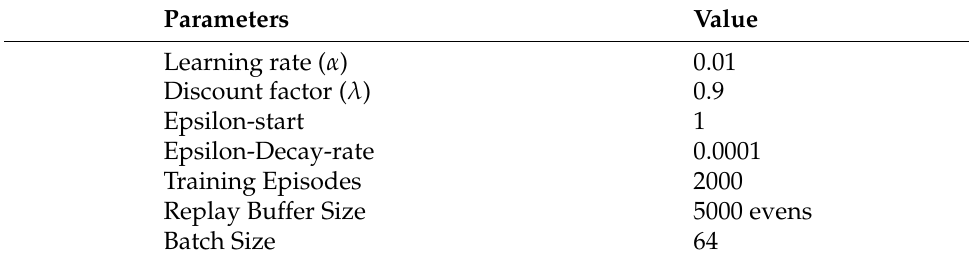
Table 2. Q-learning and DQN training